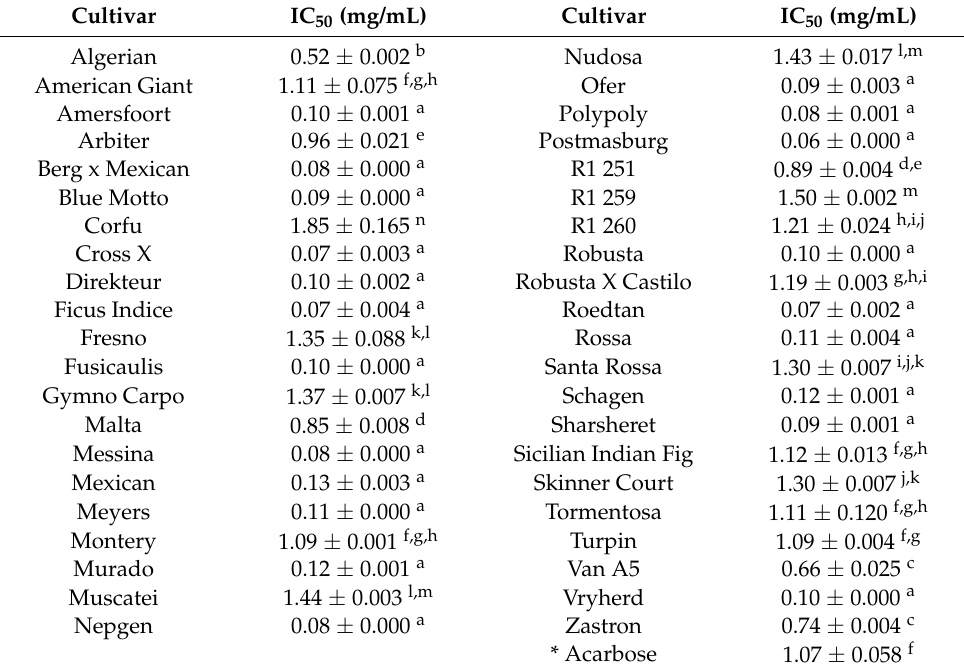
Table 2. Alpha-glucosidase inhibitory activity of cladode extracts from 42 spineless cactus pear cultivars.